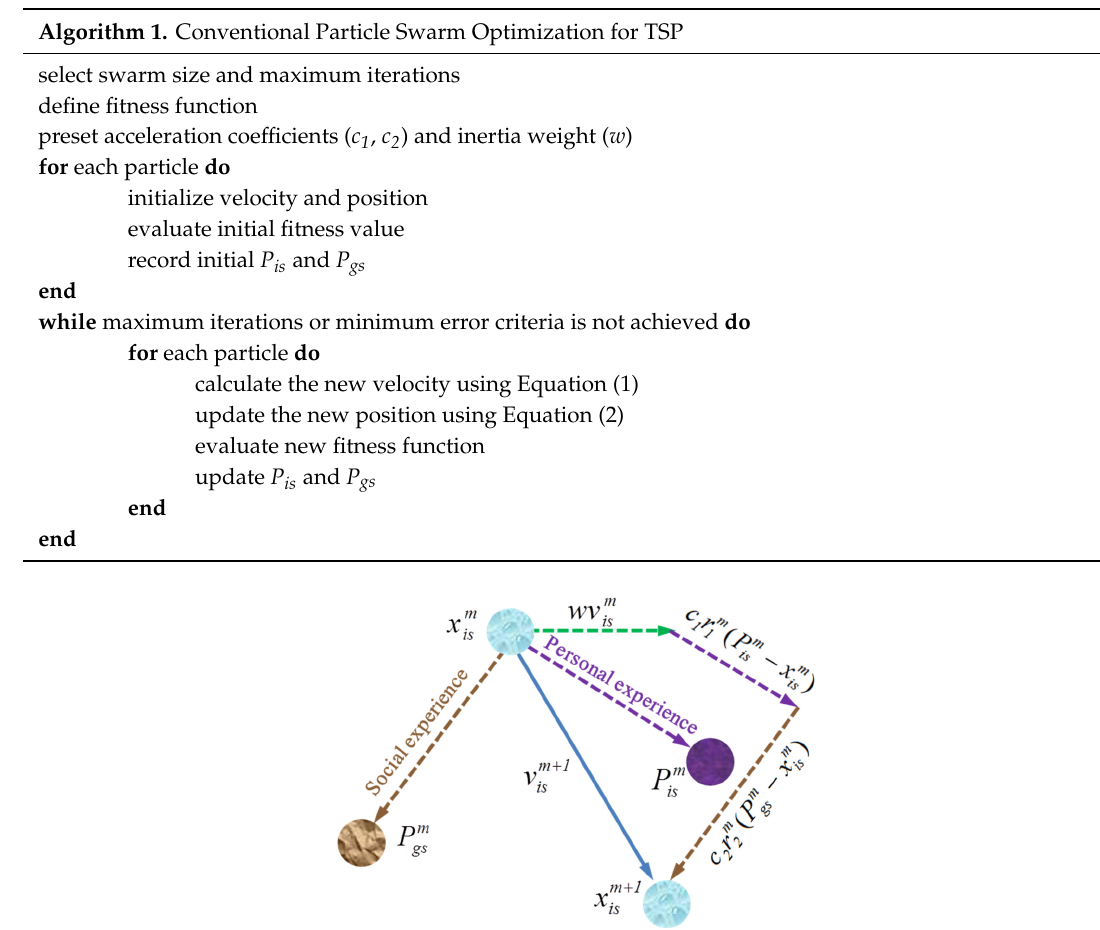
Figure 1. Shematic diagram of a particle’s position update in PSO. Algorithm 1. Conventional Particle Swarm Optimization for TSP